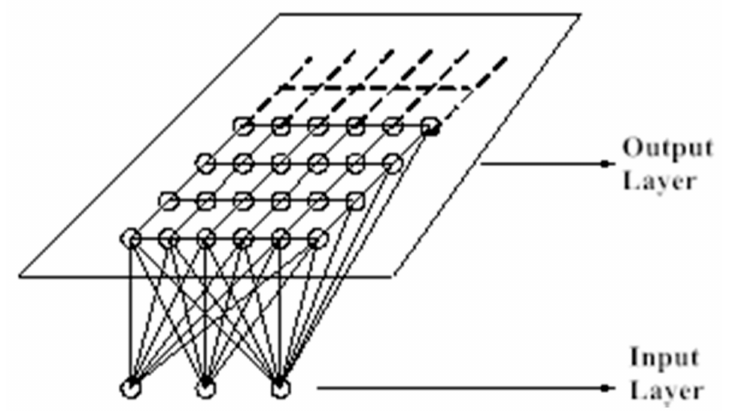
Figure 2. Two-dimensional planar array output from a self-organizing feature map (SOM).